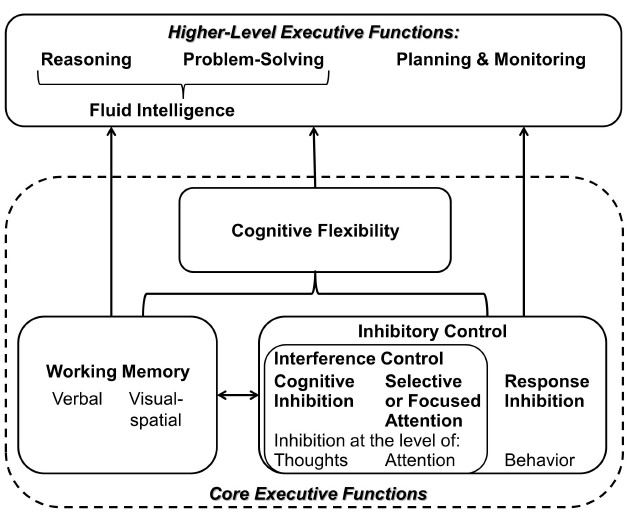
Executive functions—a set of top-down mental processes (adapted from Diamond, 2013).